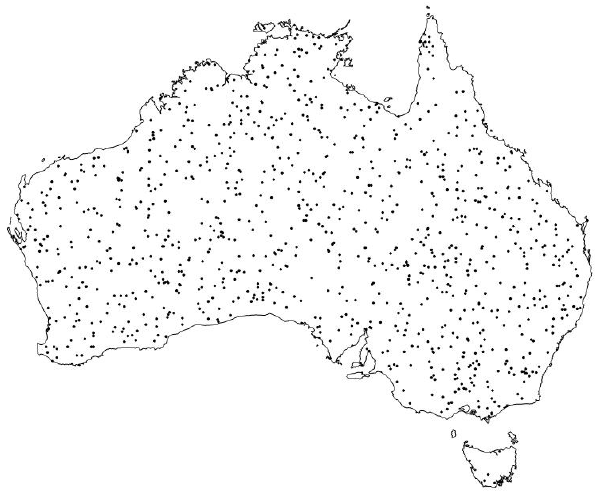
Fig. 3. Location of 1000 grid-cells, selected such that their cumula- tive distribution of modelled NPP matched that of the whole conti- nent. (For use in sensitivity analyses).